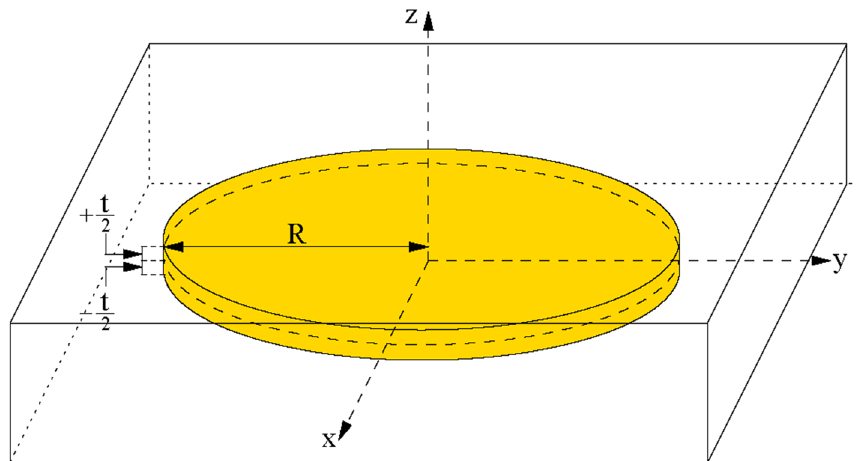
Figure 9. The simulation layout with the coordinate system definition. BAT-90 is represented by the yellow disk, whose center corresponds to the origin of the coordinate